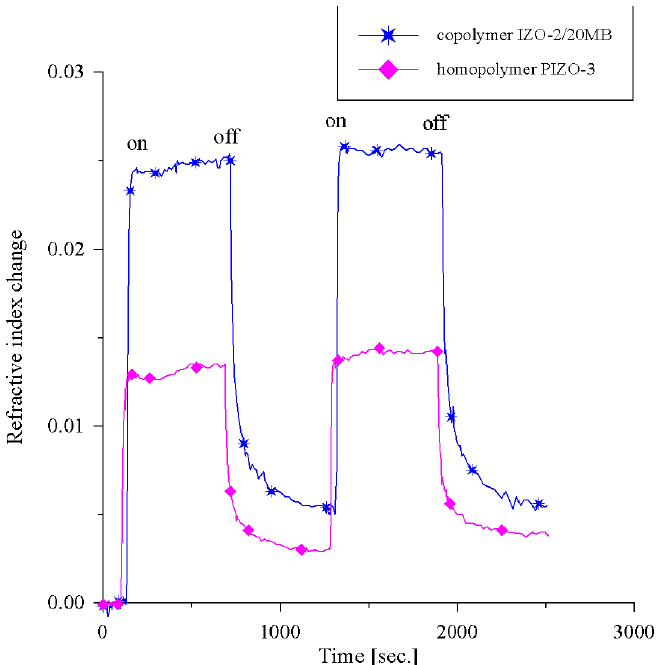
Fig. 6 Refractive index changes for IZO-2/20MB and PIZO-3 during periodic light